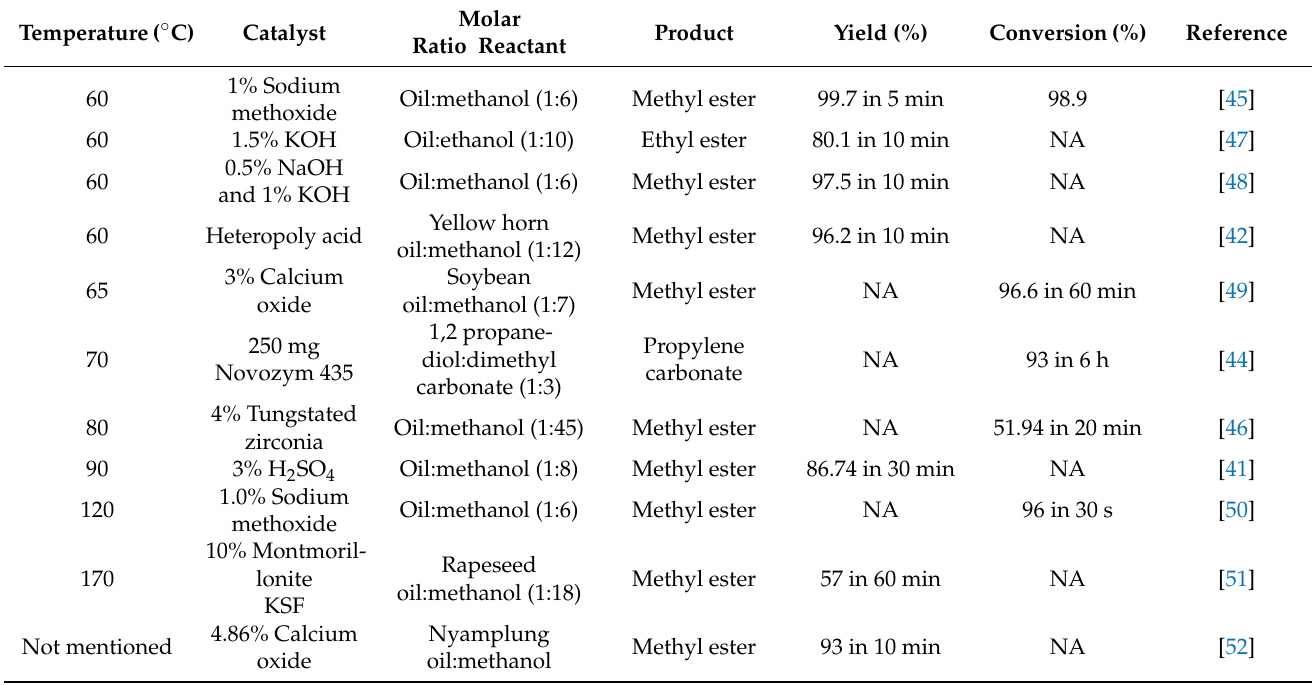
Table 2. Stand-alone microwave-assisted